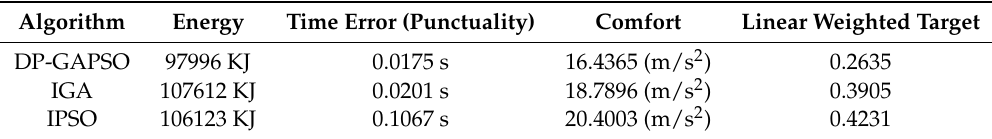
Figure 14. The iterative convergence curve of three optimization indexes from New Port in Lvshun to Tieshan town. Table 11. The optimization results obtained by the three optimization algorithms from New Port in Lvshun to Tieshan